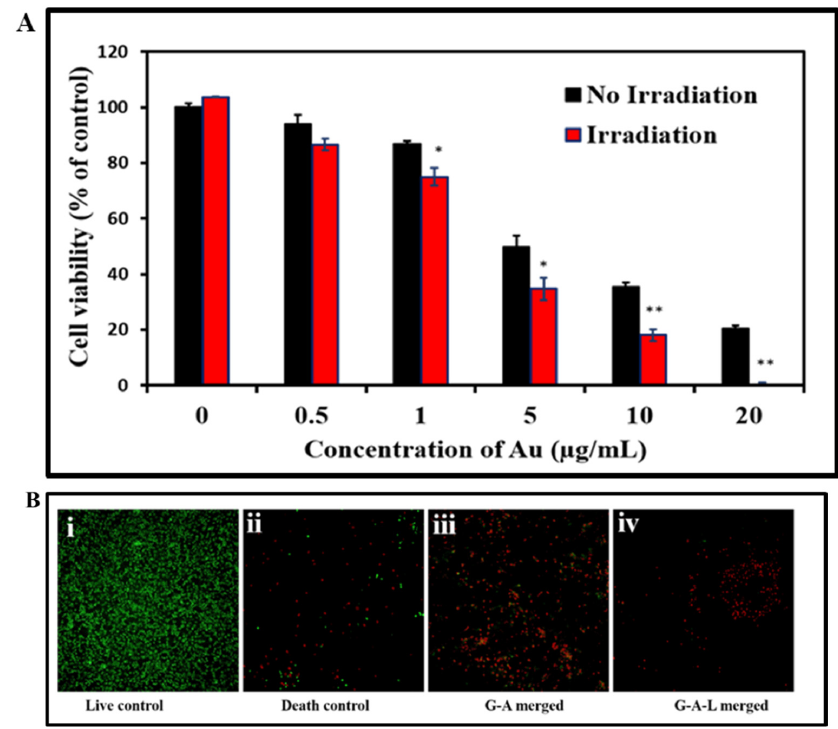
Figure 5. In vitro therapeutic effect of GNR-ANGI-2 against glioma cells. ( A ) Cytotoxicity evaluation of GNR-ANGI-2 against C6 glioma cells. Viability assay after 24 h incubation at 37 °C with subsequent NIR laser exposure of 808 nm at 1 W cm − 2 for 24 min. The results represent the means and standard deviations (SDs) of three independent experiments (* p ≤ 0.05, ** p ≤ 0.01). ( B ) C6 cells stained with calcein-AM and propidium iodide to visualize live (green) and dead (red) cells: ( B ( i )) cells alone; ( B ( ii )) cells treated with alcohol; ( B ( iii )) cells treated with GNR-ANGI-2 (20 μ g/mL Au ion concentration) for 12 h; ( B ( iv )) cells treated with GNR-ANGI-2 (20 μ g/mL Au ion concentration) exposed to laser for 24 min and incubated for 12 h.